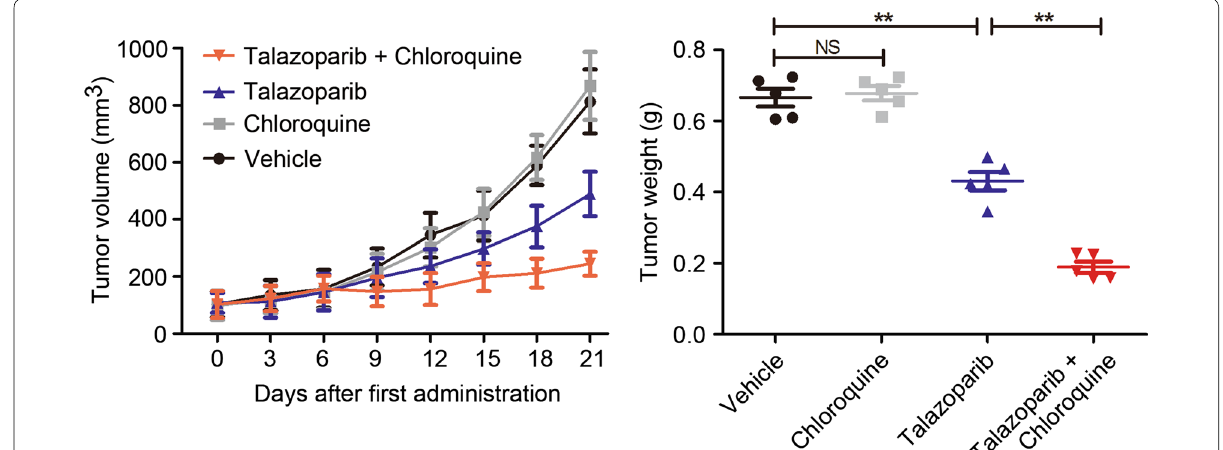
Fig. 7 Targeting PARP and autophagy elicited synergetic anti-tumor effect in pediatric CML. Patient-derived xenograft (PDX) model was established to evaluate the anti-tumor efficacy of talazoparib and/or chloroquine in CML. Tumor volume was measured once every 3 days. After treatment with talazoparib and/or chloroquine for 21 days, tumor weight was shown as mean (n 5). NS no significance; ** P < =